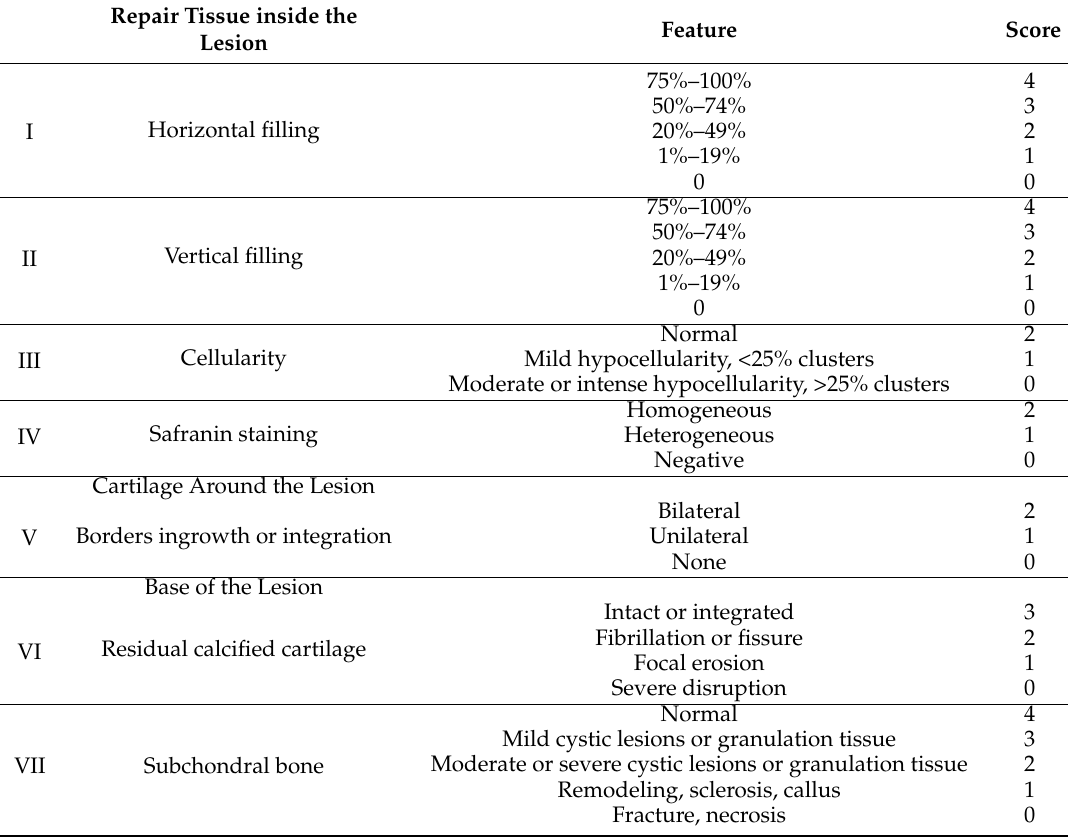
Table 4. The new Partial Thickness Model histological